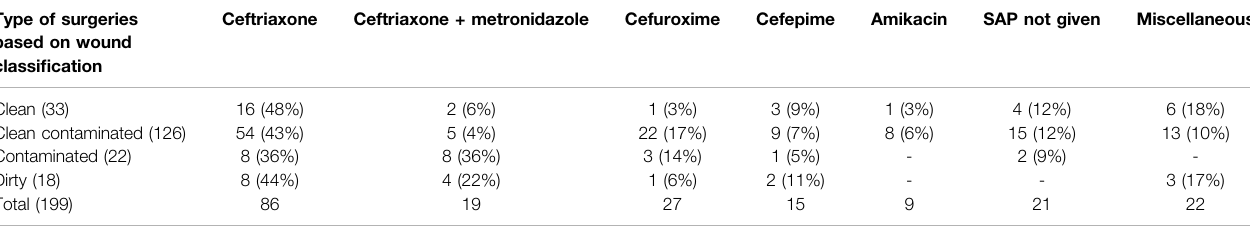
SAP, surgical antimicrobial prophylaxis.